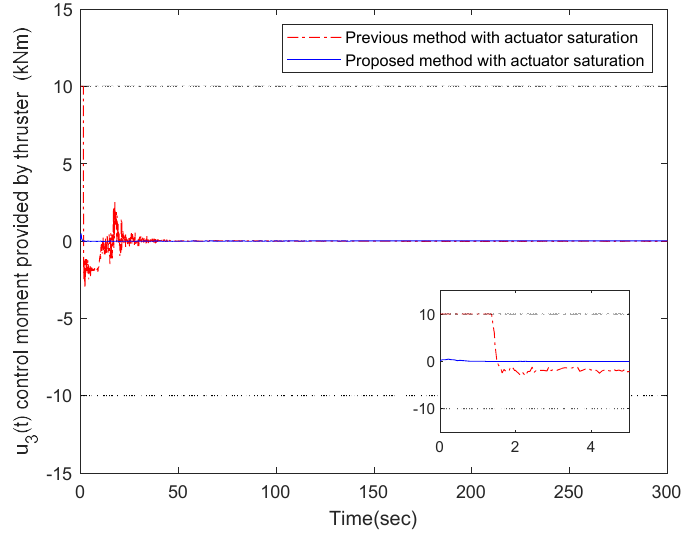
Figure 12. The responses of u 3 ( t ) compared with [29].